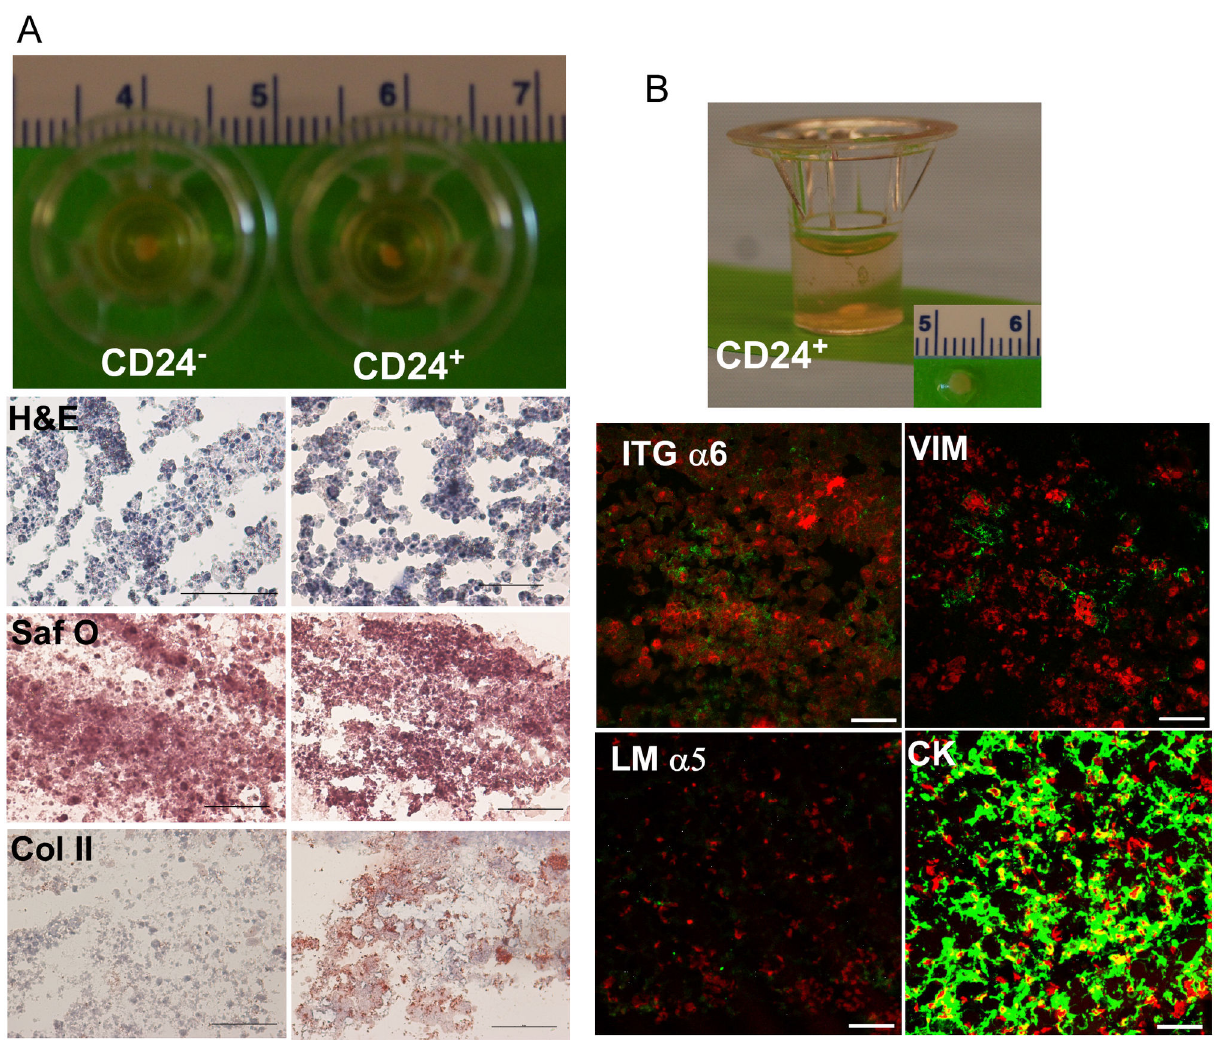
Figure 4. Differentiation of enriched CD24 + iPSCs in a 3D culture system in vitro . (A) Cell constructs form both CD24 - and CD24 + fractions extracted from Transwells at the end of culture (day 28) and representative images of histology and immunostaining revealed cell morphology (H and E) and matrix accumulation (Saf O for glycosaminoglycan and type II collagen, Col II; Scale bar: 50 µm). (B) CD24 + cell construct and representative images for expression of NP-associated markers by immunostaining (integrin α6, ITGα6; laminin α5, LM α5; vimentin, VIM and cytokeratin 5/8, CK) in cell constructs at day 28. Scale bar: 20